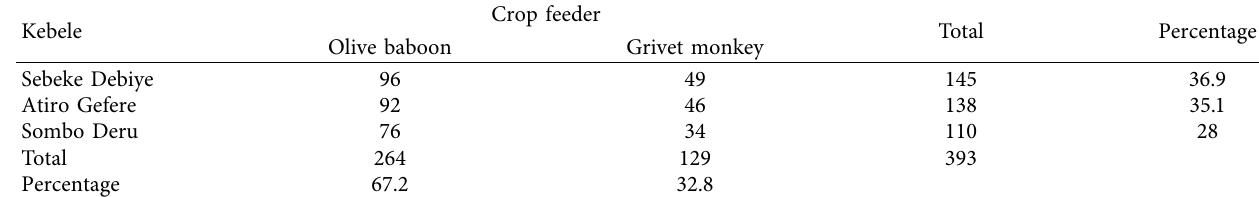
Table 5: Feeding events by diferent primate species in each